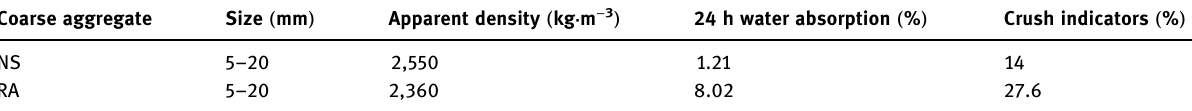
Table 4: Physical properties of coarse aggregate Coarse aggregate